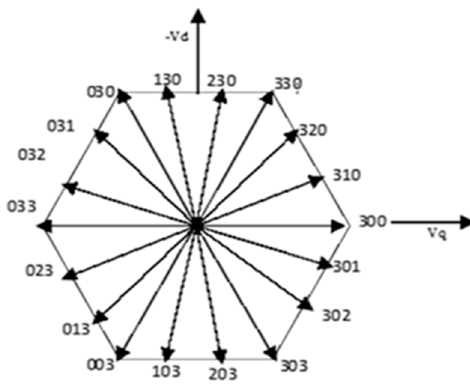
Figure 2. Switching state vectors for 4LT 2 C [28]. Table 1. Voltage transition and switching states in leg a.